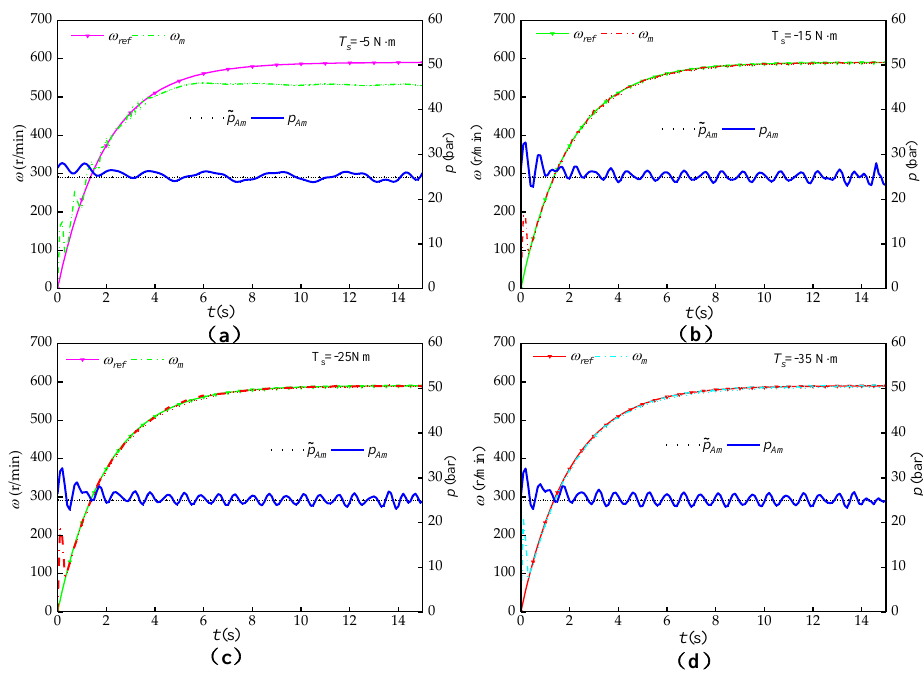
Figure 9. EPCBV system responses under different negative torque T s ( a ) T s = − 5 N · m, ( b ) T s = − 15 N · m, ( c ) T s = − 25 N · m, ( d ) T s = − 35 N ·